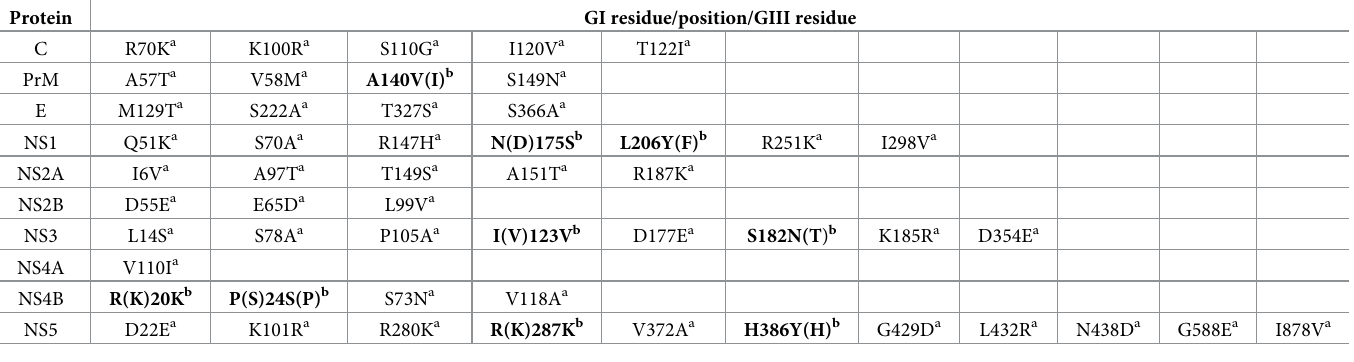
In contrast to the cells infected with rGI and rGIII, no NS5 protein was detected in the cells infected with UV-rGI or UV-rGIII (Fig 2B), indicating that both UV-rGI and UV-rGIII were inactivated and unable to replicate in DEF. Analysis of IFN- α and β expression indicated that rGI and rGIII induced both IFN- α and β expression, with significant differences in the mRNA levels between rGI and rGIII. However, UV-rGI and UV-rGIII failed to induce IFN- α and β expression (Fig 2C). The levels of IFN- α and β expression in the cells infected with UV-rGI and UV-rGIII were similar to the basal levels of IFN- α and β expression in mock-infected cells. These results indicated that viral replication was essential for IFN- α and β induction. To test whether IFN- α and β determined the differences in replication efficiency between the GI and GIII strains, DEF was treated with small interfering RNA (siRNA) to knock down IFN- α and β expression by RNA interference and subsequently infected with rGI and rGIII. In response to rGI and rGIII infection, the levels of IFN- α and β induction increased at the mRNA and protein levels in the cells treated with siRNA (siRNA+), as compared with mock- infected cells, but were significantly lower than those in the cells treated with scrambled RNA control (siRNA-) (Fig 2D and 2E), suggesting that IFN- α and β expression was silenced. Noticeably, no significant differences in IFN- α and β induction between rGI and rGIII were observed in the cells treated with siRNA (siRNA+) in the presence of rGI and rGIII infection (Fig 2D and 2E). Analysis of viral replication indicated that significant increases in replication titers of rGI and rGIII were observed in the cells treated with siRNA (siRNA+), as compared with the cells treated with scrambled RNA control (siRNA-) (Fig 2F). However, no significant